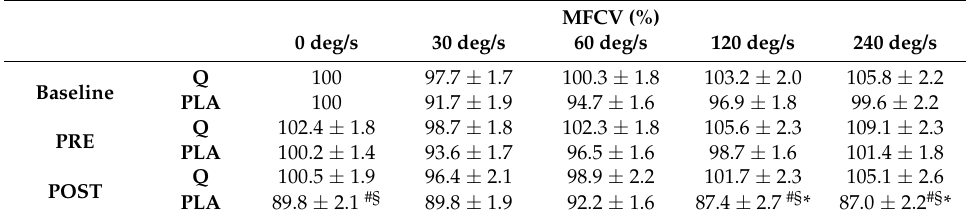
Table 1. Mean MFCV values obtained during the force–velocity (FV) relationship task in Q and PLA conditions at baseline (BASE), before (PRE) and after (POST) the eccentric exercise. Data are expressed as a percentage of